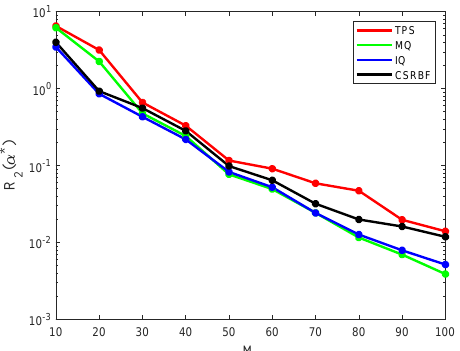
Figure 6. The graph of the variety of R 2 ( α ∗ ) with M corresponding to the four kinds of basis functions under N = 2500.